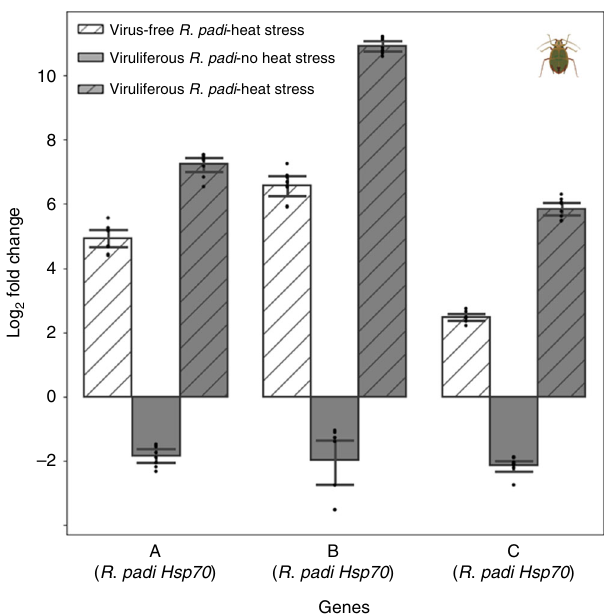
Fig. 4 Expression levels of three heat-shock protein genes in R. padi individuals differing in infection status and with and without heat stress (at CT Max ). Expression levels are relative to those observed for virus-free aphids in the absence of heat stress (Hsp70 A: Student ’ s t- test = 9.81, df = 34, P ≤ 0.0001; Hsp70 B: t test = 6.45, df = 34, P ≤ 0.0001). Values higher than 0 indicate increased gene expression, whereas values lower than 1 indicate gene suppression. Signi fi cant fold changes compared with R. padi virus-free are indicated, and bars represent mean ± SE ( n = 8 per treatment). Source data are provided as a Source data fi